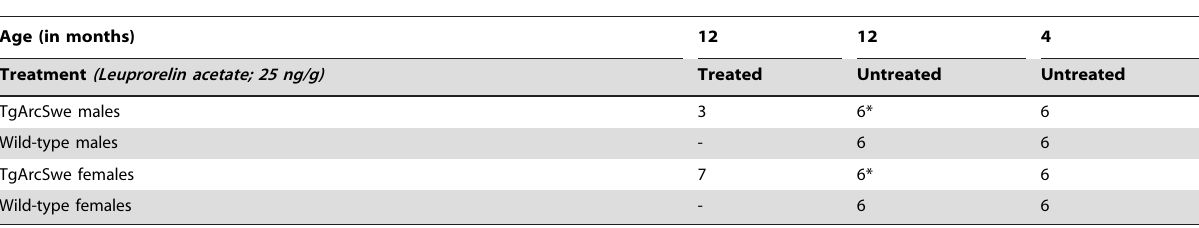
Table 1. Animals involved in the study.